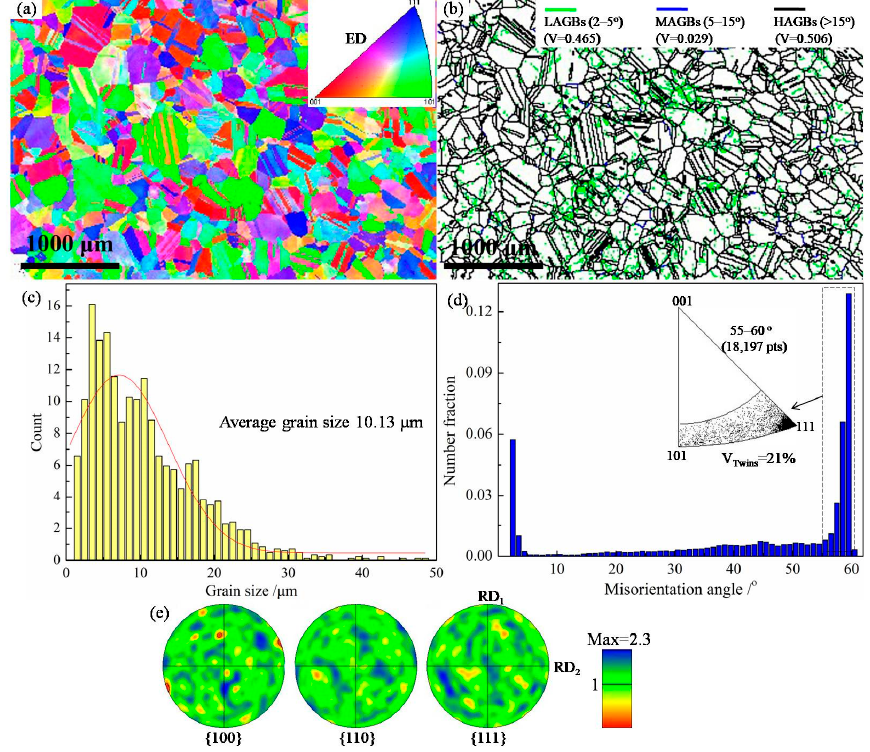
Figure 2. Microstructure of the as-received bar under EBSD measurement: ( a ) inverse pole figure image; ( b ) grain boundary map; ( c ) grain size distribution; ( d ) histogram of the misorientation angle and the inset showing distribution diagram of angular axis of Σ 3 twin; and ( e ) pole figure (PF).